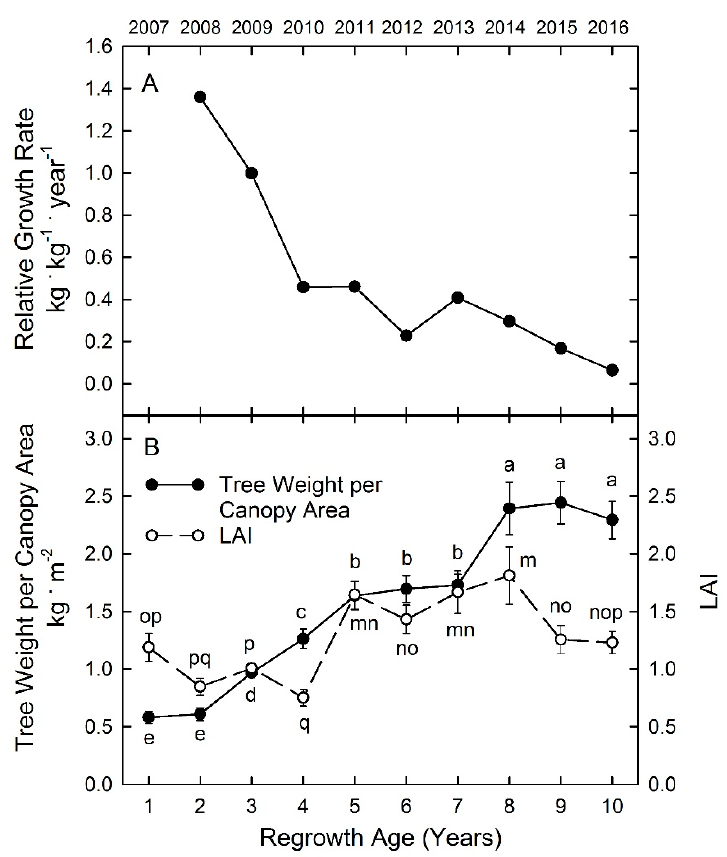
Figure 7. Regrowth age vs relative growth rate ( A ), and regrowth age vs mesquite tree weight per canopy area, and vs. LAI ( B ). Vertical bars on means in panel B indicate ±1 standard error. Means with different letters across all ages (panel B), are significantly different at p ≤ 0.05 for tree weight per canopy area (a – e) or LAI (m – q). Values in panel A were derived from means and have no statistical analysis.